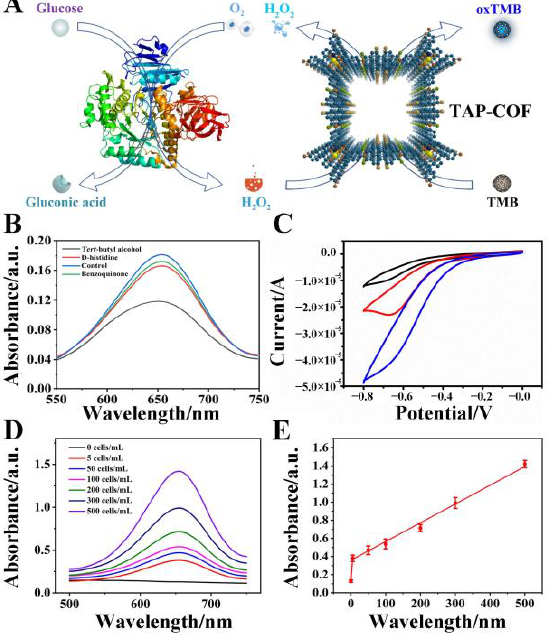
Figure 5. ( A ) Diagrammatic representation of the blue-colored oxTMB produced in cells by the INAzyme-catalyzed cascade oxidation of glucose and TMB. ( B ) ROS trapping experiment. The TMB oxidation process in the presence of D-histidine ( 1 O 2 scavenger), tert-butyl alcohol ( · OH scavenger), and benzoquinone (O 2 •− scavenger). ( C ) CV curves of different electrodes, GCE electrode (black line), FeTAPP/GCE (red line), TAP-COF/GCE (blue line). TAP-COF-based colorimetric examination of MCF-7 cells in binding buffer for quantitative analysis of ( D ) UV-vis absorption spectroscopy and ( E ) linear calibration of MCF-7 cells detection.